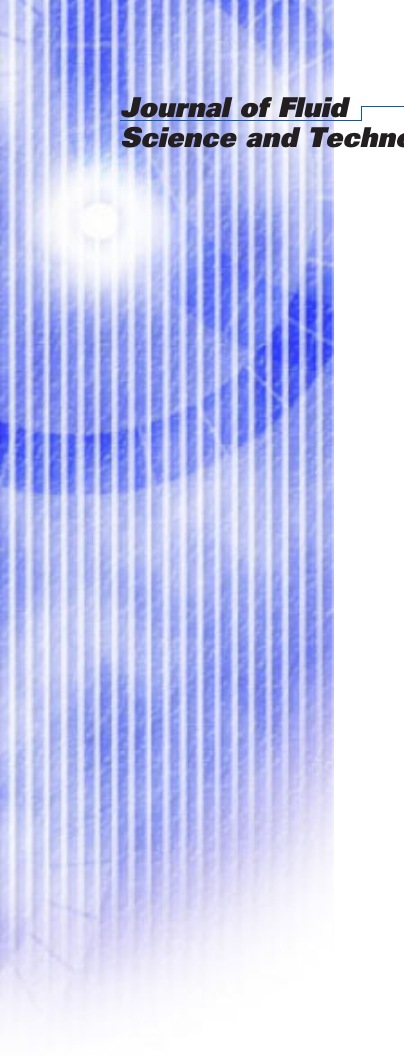
where x i is the discrete data and Δ t is the sampling